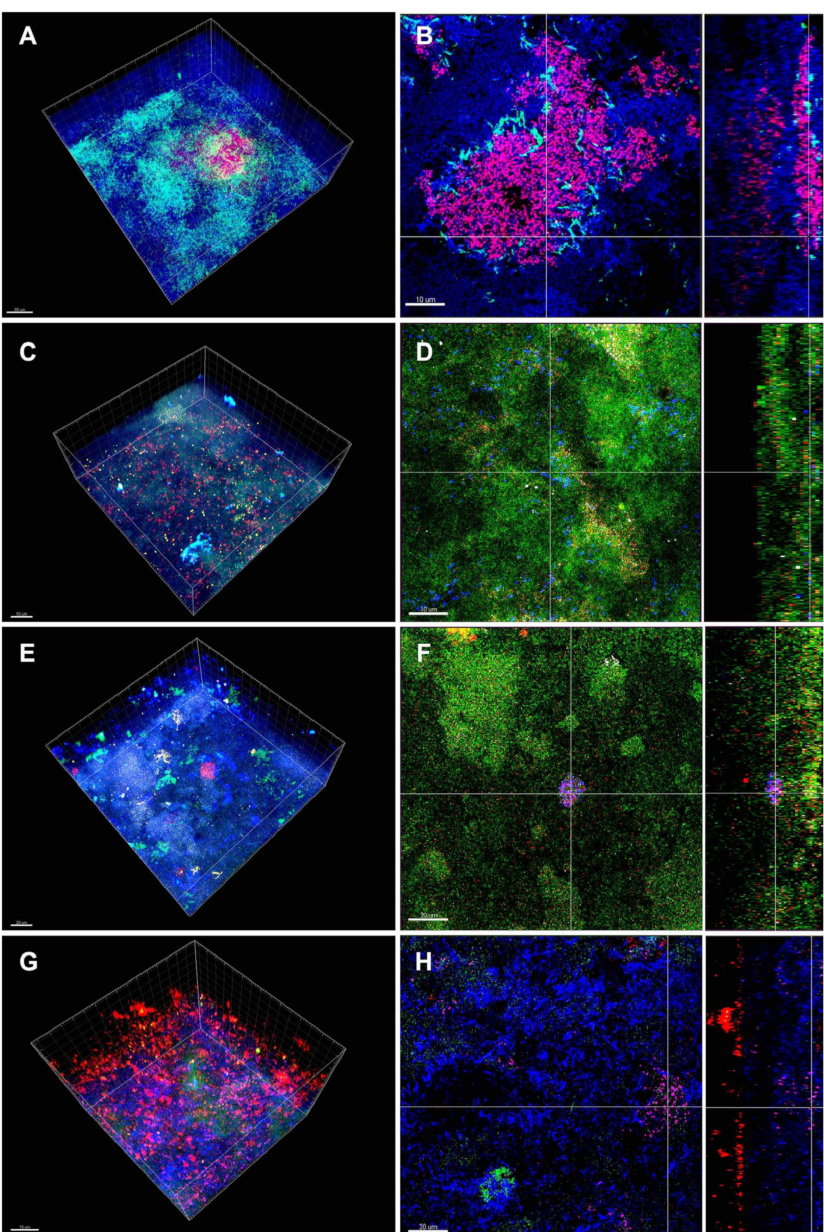
Figure 7. Confocal laser scanning microscopy (CLSM) 3D reconstructions of the endodontic-like 15-species biofilms grown on HA discs following fluorescence in situ hybridization (FISH). To form endodontic-like multispecies biofilms, a total of six bacterial species were added to a “basic” nine-species subgingival biofilm. The resulting endodontic-like 15-species biofilms contained F. nucleatum (light blue; FITC-labeled) and P. intermedia (red; Cy3-labeled) ( A , B ); E. faecalis (green; FITC-labeled), P. micra (red; Cy3-labeled), S. aureus (yellow; ROX-labeled) ( C , D ); P. nigrescens (green; FITC-labeled), S. sputigena (red; Cy3-labeled), T. denticola (white; ROX-labeled) ( E , F ); P. gingivalis (green; FITC-labeled), T. forsythia (red; Cy3-labeled), P. intermedia (purple; ROX-labeled), F. nucleatum and C. rectus (blue; Cy5-labeled) ( G , H ). In images ( A – F ), non-hybridized bacteria appear blue due to DNA staining (YoPro 59). Scale bar = 10 µ m ( A – E , G ) or 20 µ m ( F , H